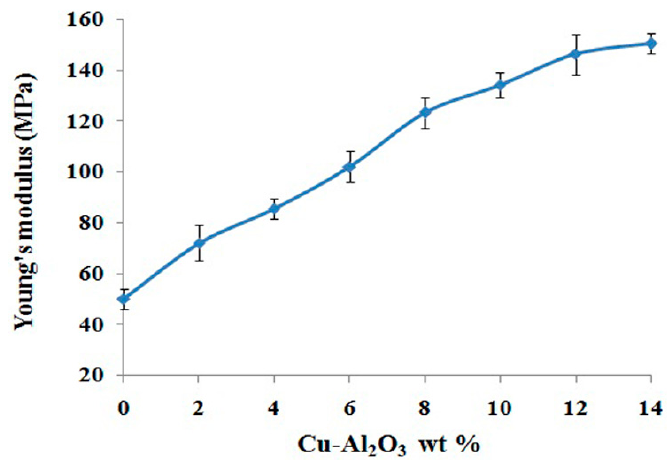
Figure 8. Young’s modulus of Cu–Al 2 O 3 /PS- b -(PE- r -B)- b -PS- g -MA composites.